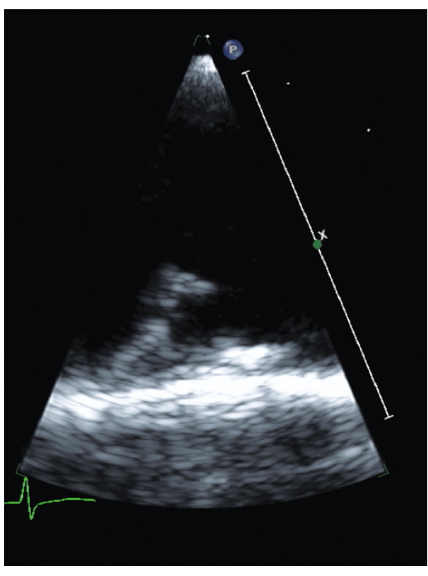
Figure 2: Long-axis TEE view revealing mobile atheromatous